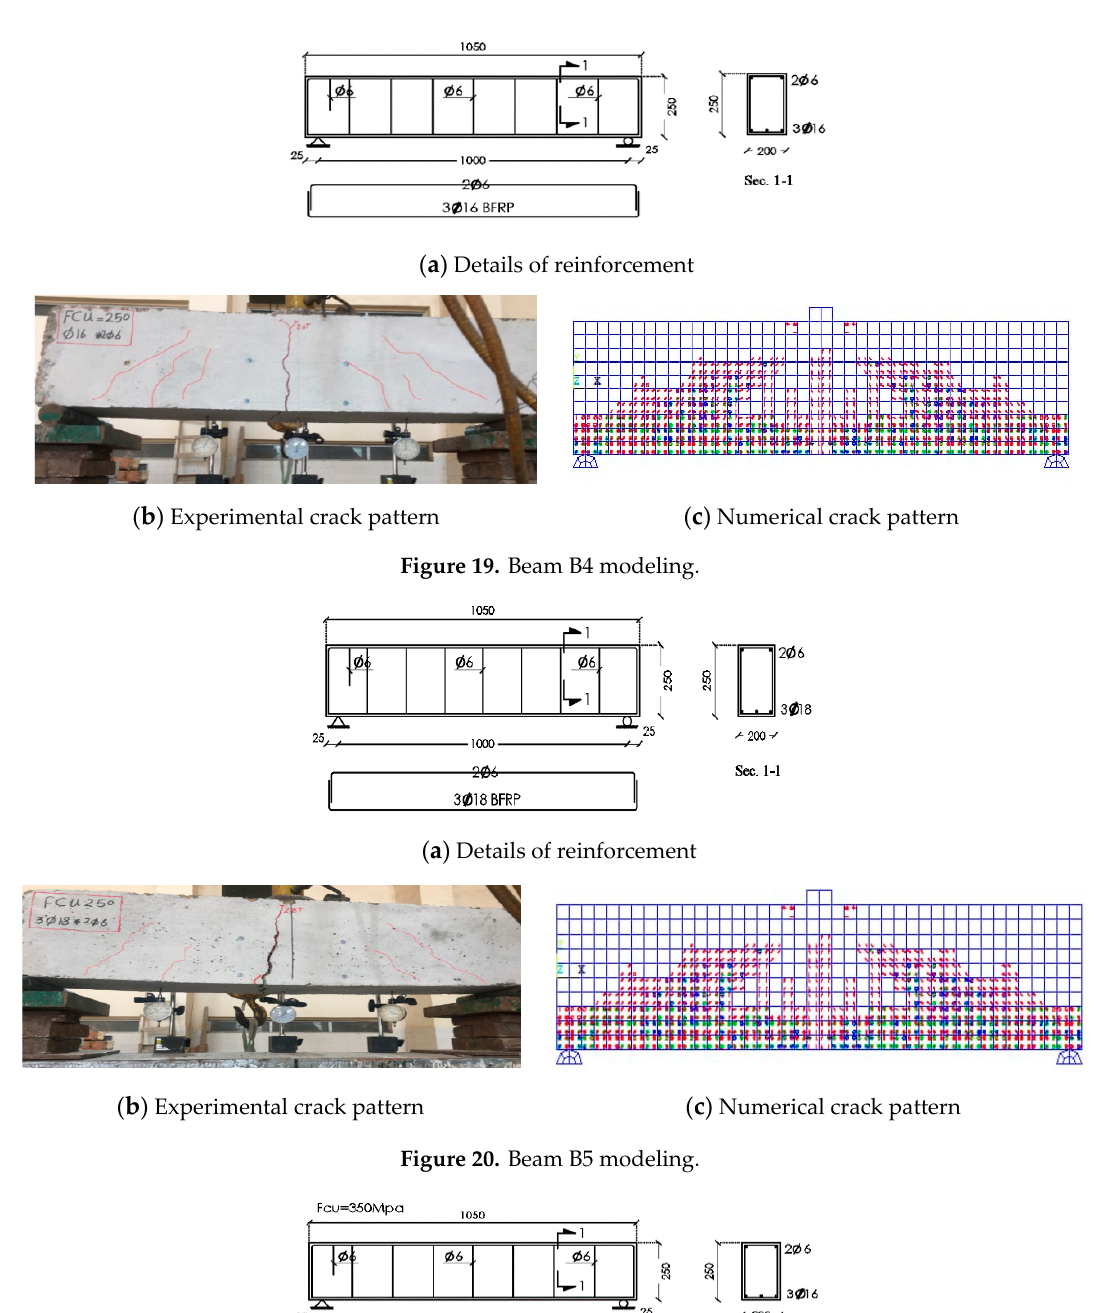
Figure 18. Beam B3 modeling.